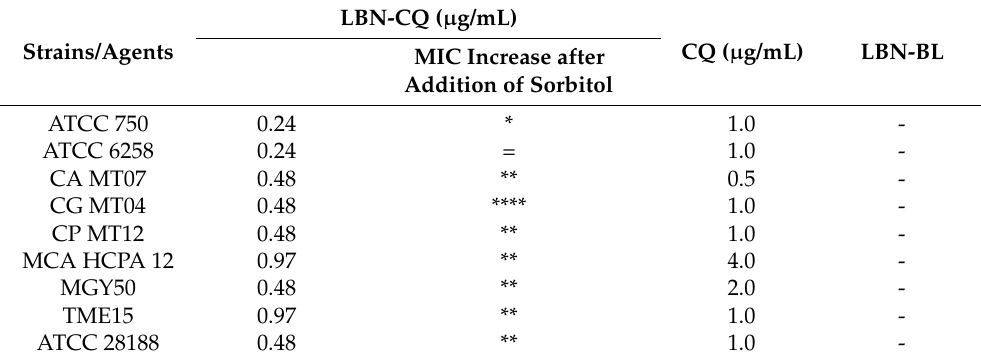
Table 1. Minimum inhibitory concentration (MIC) values at µ g/mL for LBN-CQ, LBN-BL and CQ in solution against yeasts and